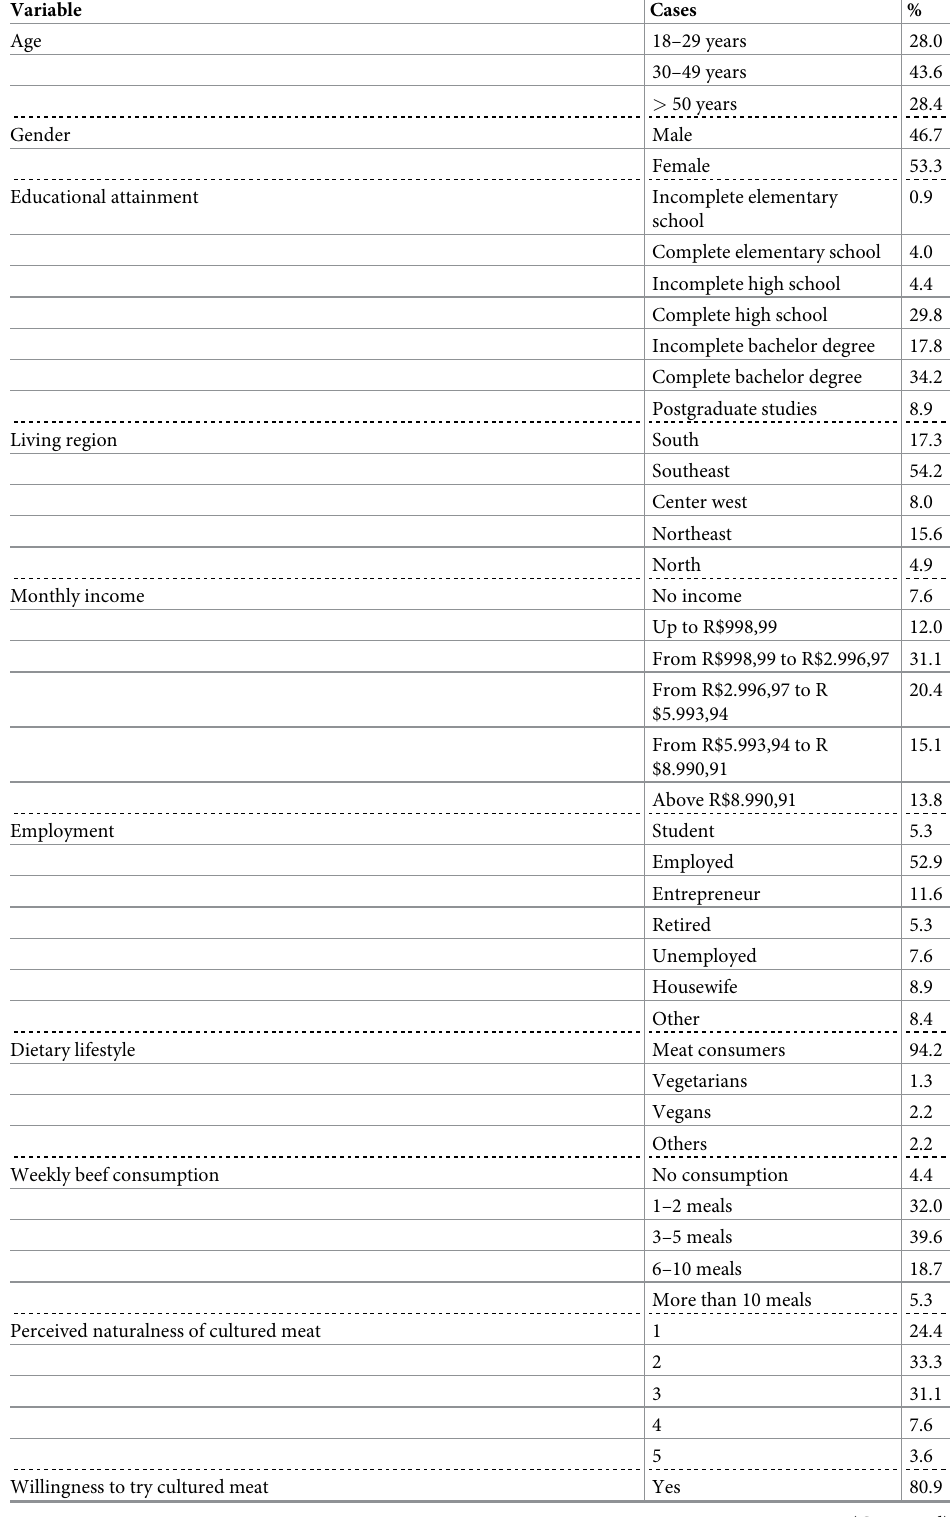
Table 2. Demographics and food consumption